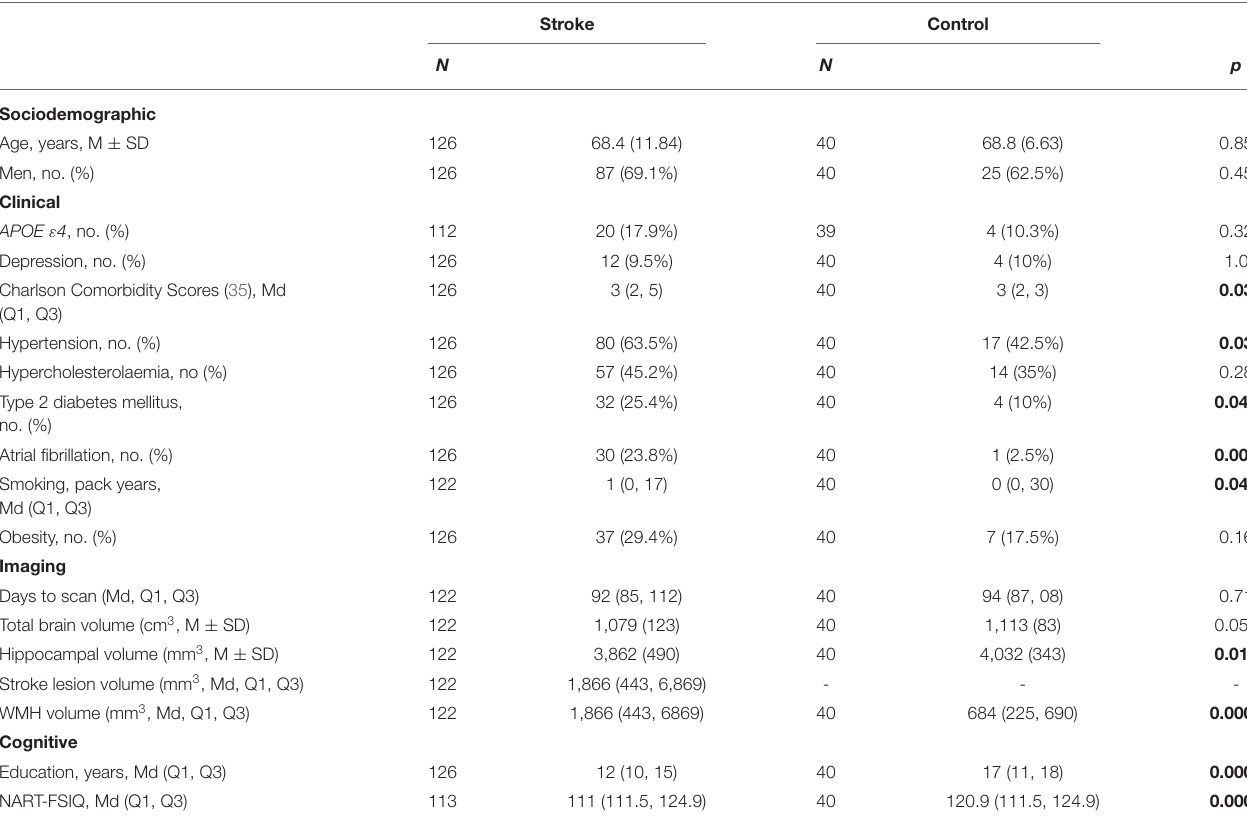
TABLE 2 | Characteristics of stroke and control participants attending the 3-month assessment. Stroke Control